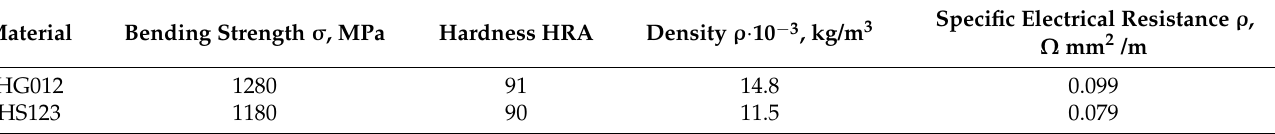
Table 2. The physical-mechanical properties of HG012 and HS123 hard alloys.